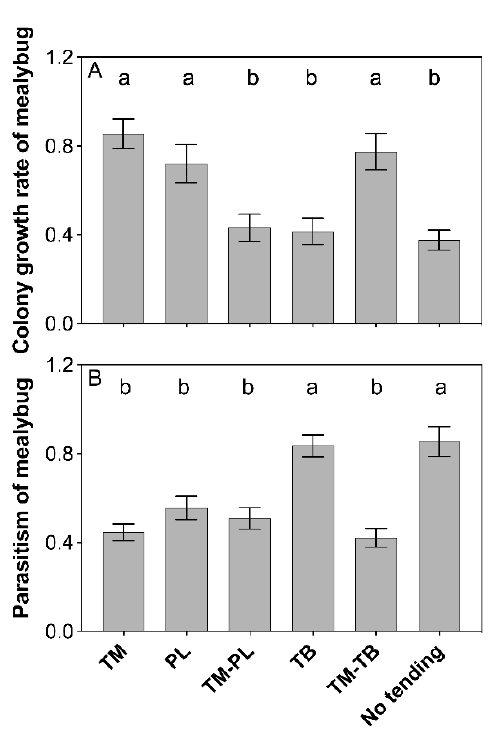
Figure 1. Effects of interference competition on mealybug populations. ( A ) colony growth rate of mealybug; ( B ) parasitism of mealybug. The data are presented as the mean ± SE. Bars sharing the same letters indicate no significant differences among the treatments ( P > 0.05). Colony growth rate was treated by log10-transformation, and the percent of parasitism on the mealybugs was treated by the arcsine square root-transformation. Tapinoma melanocephalum , Paratrechina longicornis , Tetramorium bicarinatum , Tapinoma melanocephalum - Paratrechina longicornis confrontation and Tapinoma melanocephalum - Tetramorium bicarinatum confrontation were abbreviated into TM, PL, TB, TM-PL and TM-TB, respectively.